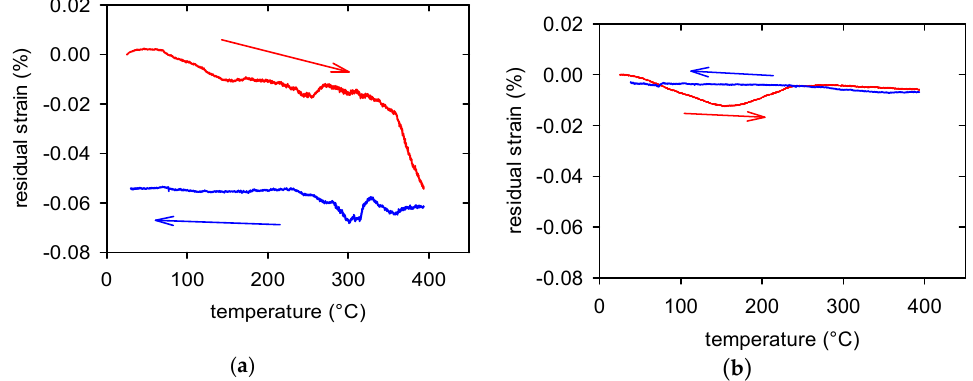
Figure 7. Temperature dependence of the residual strain while heating and cooling for swaged ( a ) and swaged and aged material ( b ).